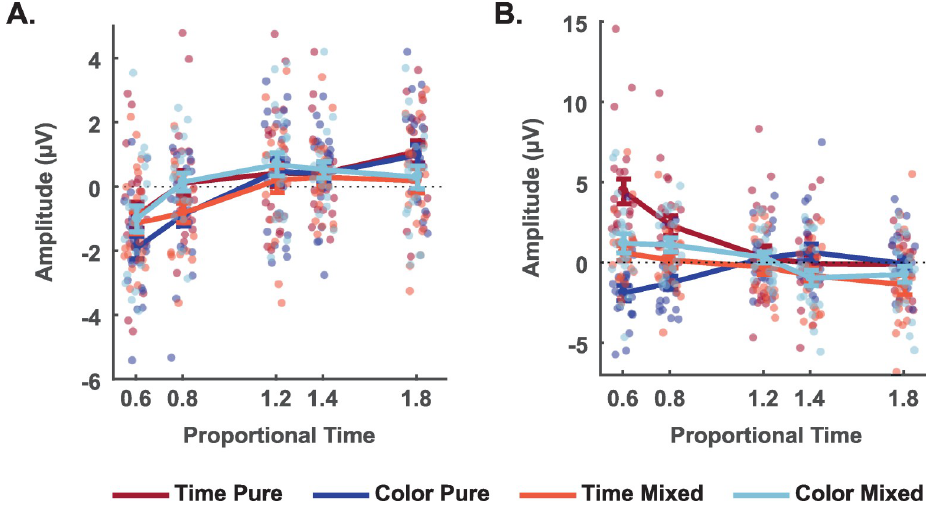
Fig 5. ERP amplitude and proportional time and (A) early post-interval activity at the parietal-occipital electrodes, and (B) late post-interval activity at fronto-central electrodes. (A) Mean amplitude at parietal-occipital electrodes (P8, P6, P4, P3, P5, P7, PO8, PO4, POz, PO3, PO7, O1, Oz, O2) in the 200ms to 300ms after S2 offset window, by proportional time and task. (B) Mean amplitude at fronto-central electrodes (F1, Fz, F2, FC1, FC2, C2, Cz, C1, CP1, CPz, CP2) in the 300ms to 500ms after S2 offset window. Faint-colored circles depict individual values, while sharp-colored circles represent the mean between subjects. Bars represent the standard error of the mean. (electrodes: P8, P6, P4, P3, P5, P7, PO8, PO4, POz, PO3, PO7, O1, Oz, O2) that has a positive correlation with time across all conditions. A second fronto-central pattern of activity (elec- trodes: F1, Fz, F2, FC1, FC2, C2, Cz, C1, CP1, CPz, CP2) shows a negative correlation between